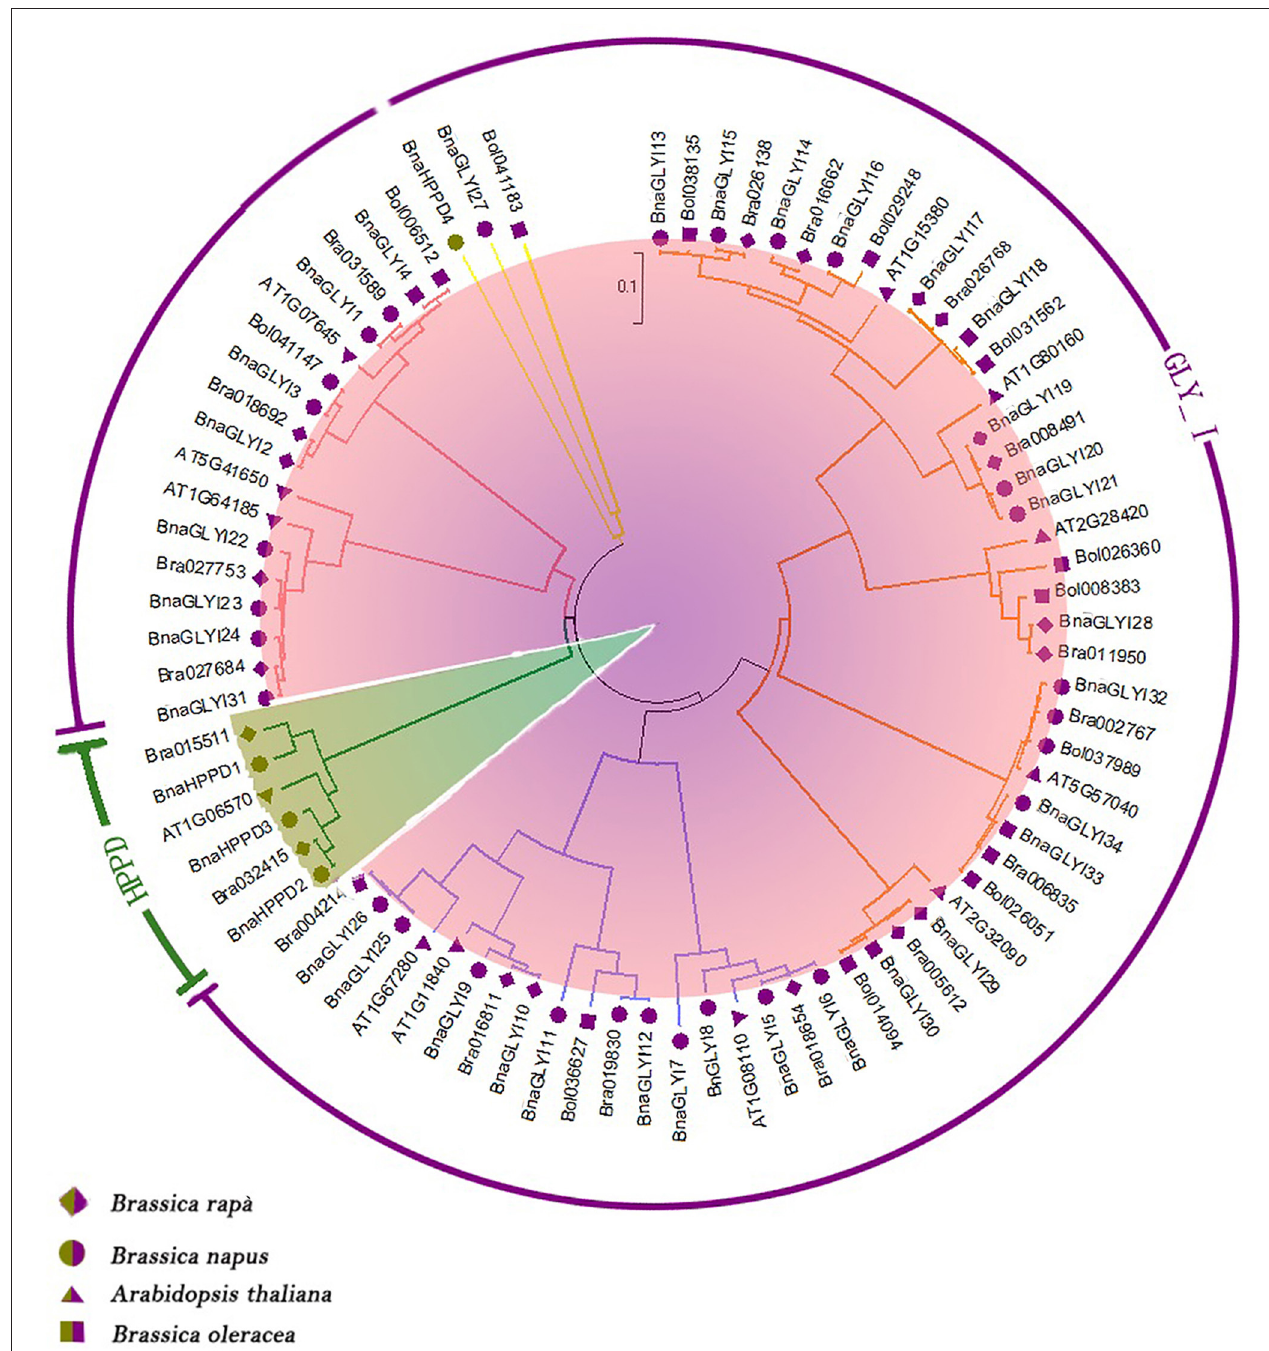
FIGURE 1 | Phylogenetic analysis of the B. napus, B . rapa, B. oleracea, and A. thaliana VOC genes. VOC gene families are distinguished by different colors. The unrooted tree was generated by using ClustalW in MEGA with the full-length amino acid sequences of the VOC proteins.